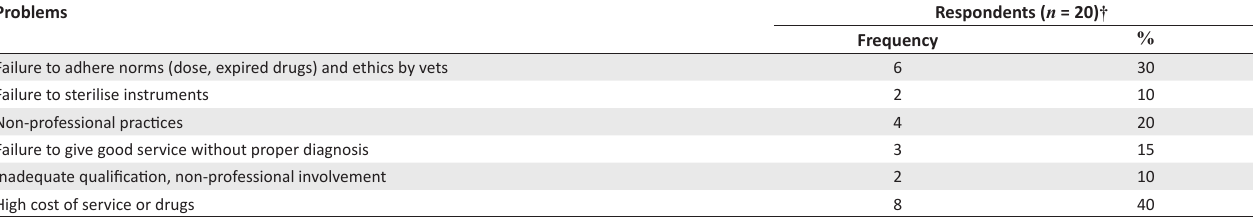
TABLE 7: Constraints in private veterinary service.